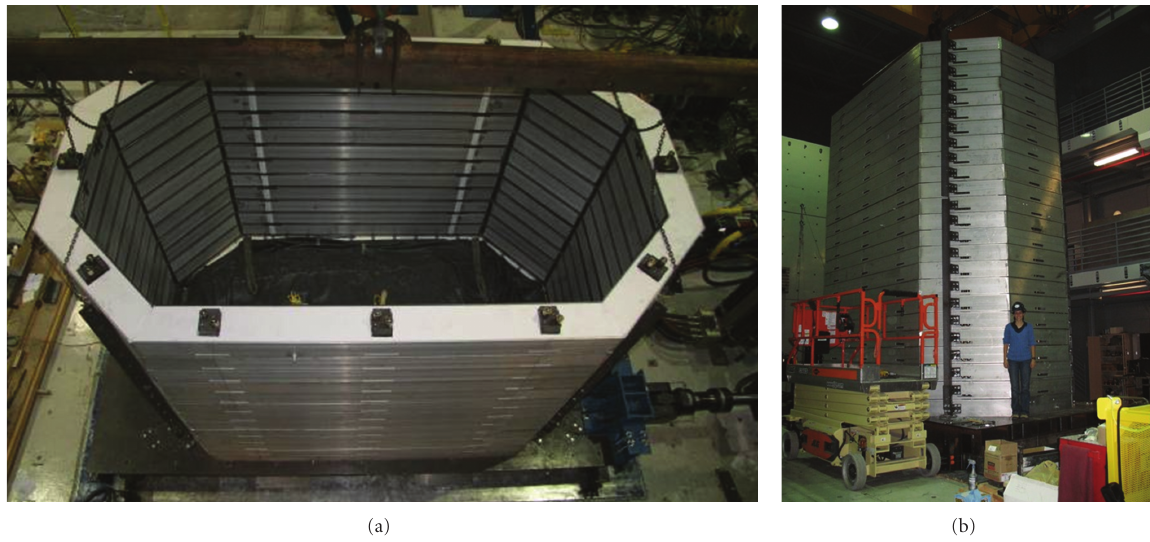
Figure 2: Assembly of laminar container at the University at Bu ff